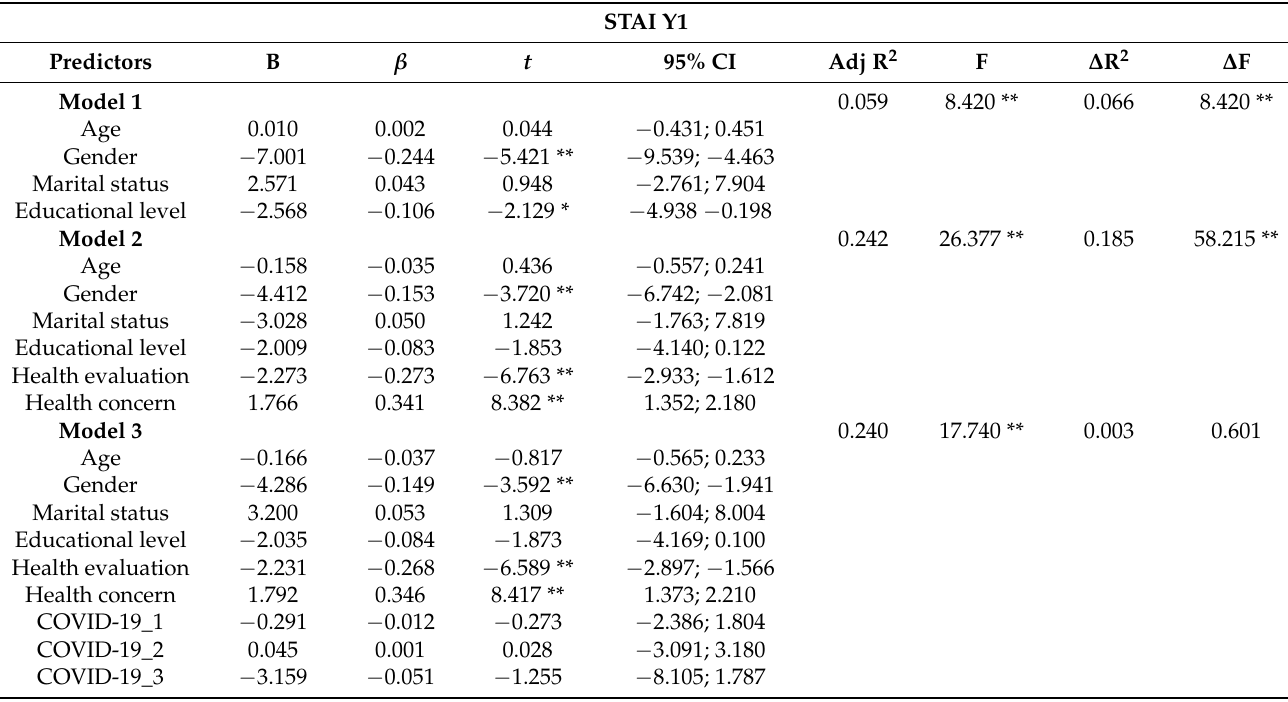
Table 2. Hierarchical multiple regression predicting STAI Y1 scores from sociodemographic variables, health-related items, and COVID-19-related questions in the student group ( N =